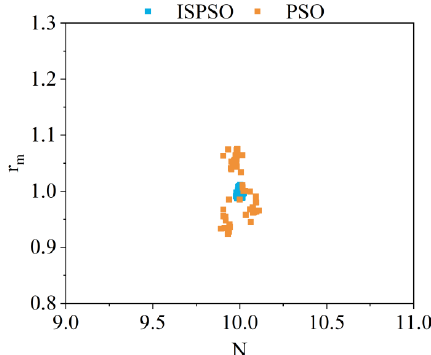
Figure A2. The 50-times calculation results of ( N , r m ).